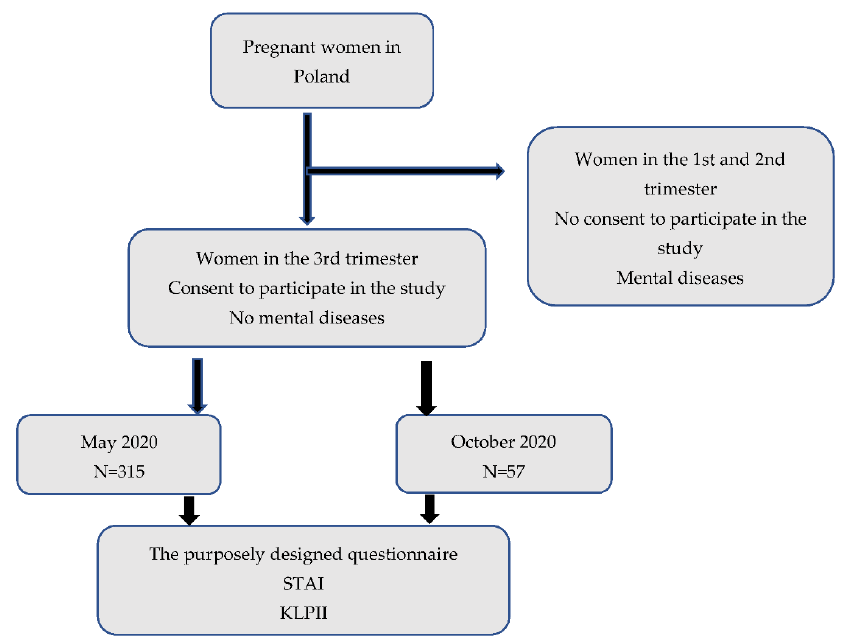
Figure 1. Study design.